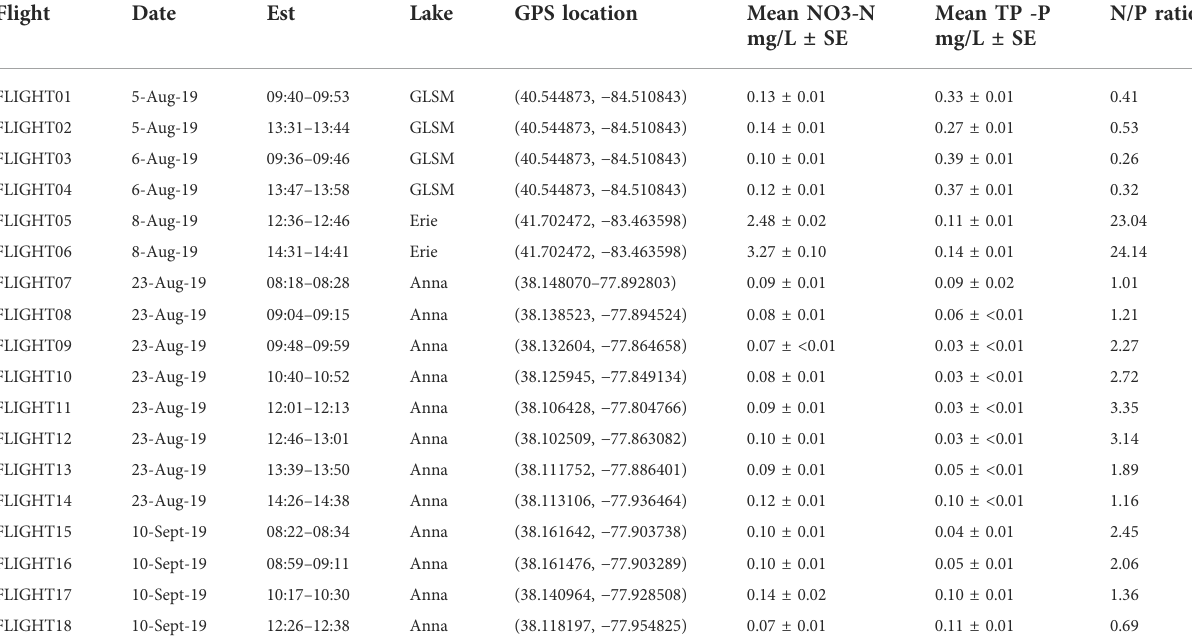
TABLE2Detailsforeachofthedrone fl ightsincludingdateofcollection,lake(GrandLakeStMary ’ s,Erie,orAnna),time(24-h),GPSlocationoflaunch site on ground or from boat, Nitrate-N (mg/L), total phosphorus (mg/L), and N/P ratio.